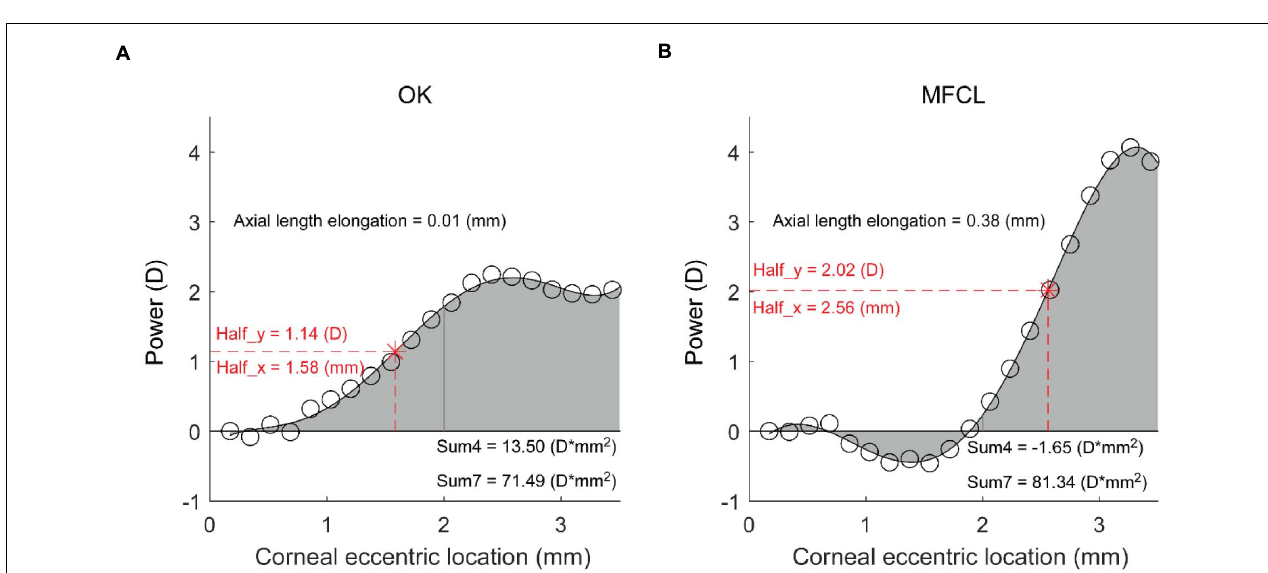
Frontiers in Neuroscience |